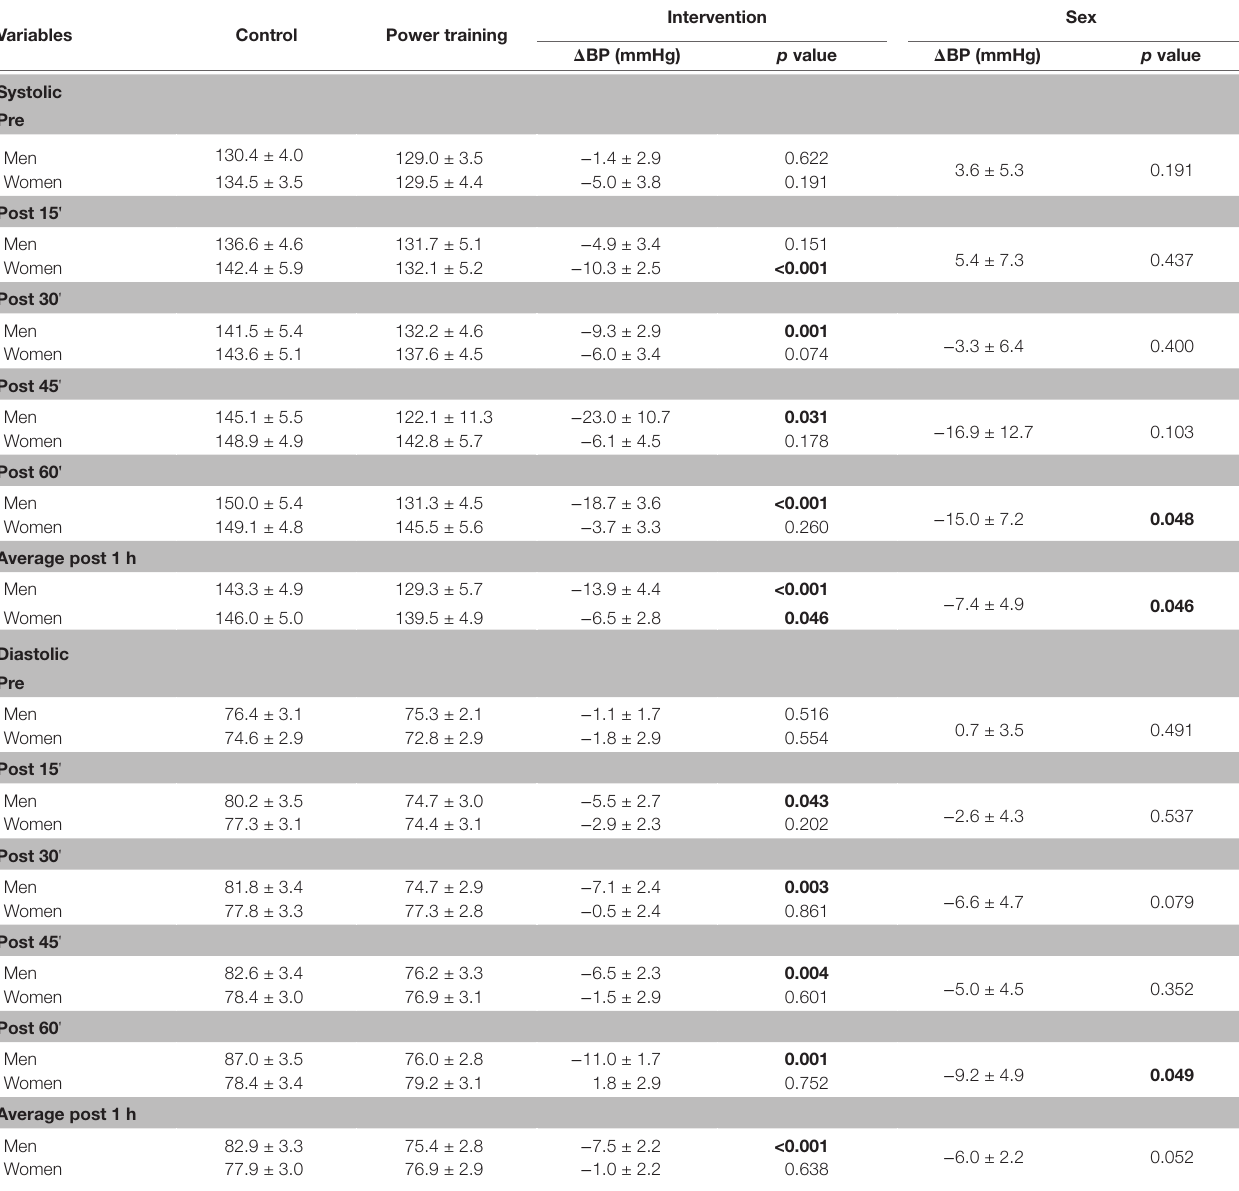
TABLE 2 | Office blood pressure measures before (pre) and after (for 1 h) the power training and control sessions in men and women.